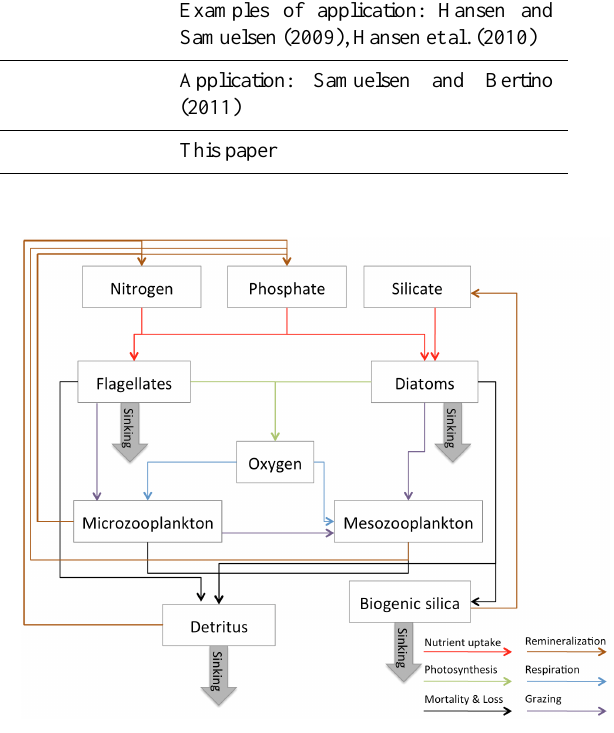
Figure 2. Flowchart of the interaction between the individual model components in